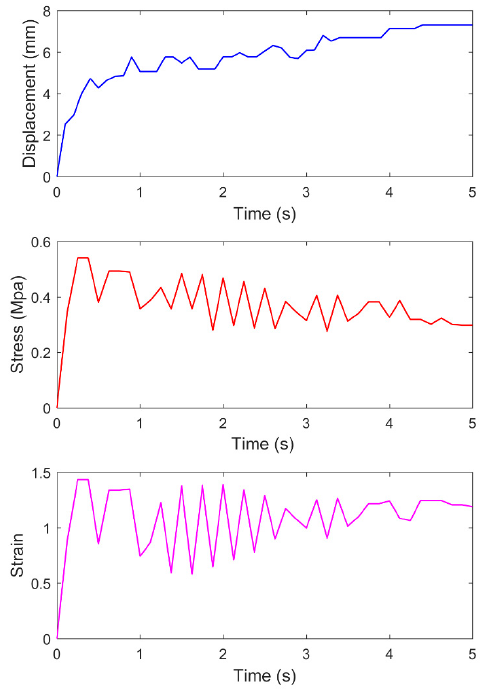
Figure 10. Curves of displacement, stress, and strain of surface monitoring points with time.